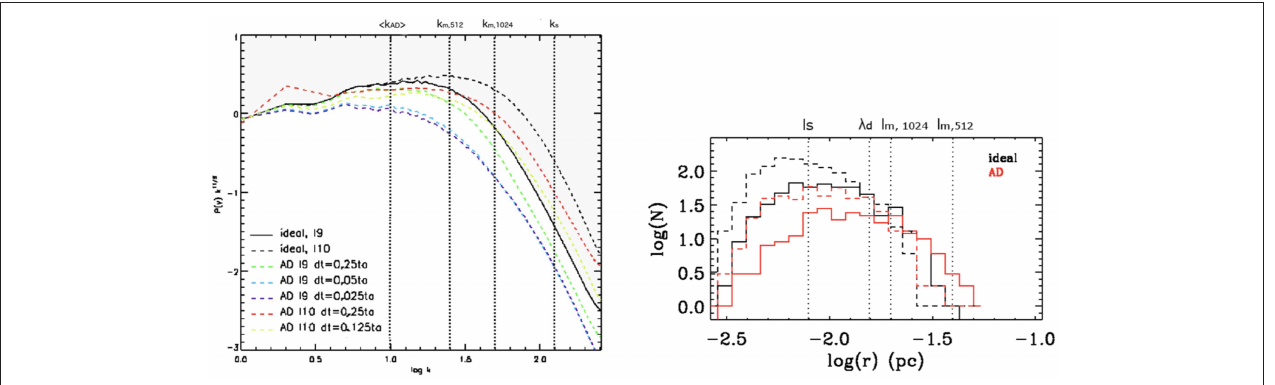
FIGURE 5 | (Left panel) Compensated velocity powerspectra for the decaying MHD simulations with ambipolar diffusion (from Ntormousi et al., 2016). The various runs include ideal MHD with 512 3 (l9) and 1024 3 (l10) resolution and a series of runs with ambipolar diffusion with the same two resolutions and various values of the minimum timesteps allowed. The powerspectra present major deviation from the ideal MHD runs at scales smaller than the ambipolar diffusion one. (Right panel) Distribution of filament width in MHD simulations with and without ambipolar diffusion. The solid lines are for a resolution of 512 3 while the dashed ones correspond to 1024 3 . Reproduced from Ntormousi et al. (2016) with permission of